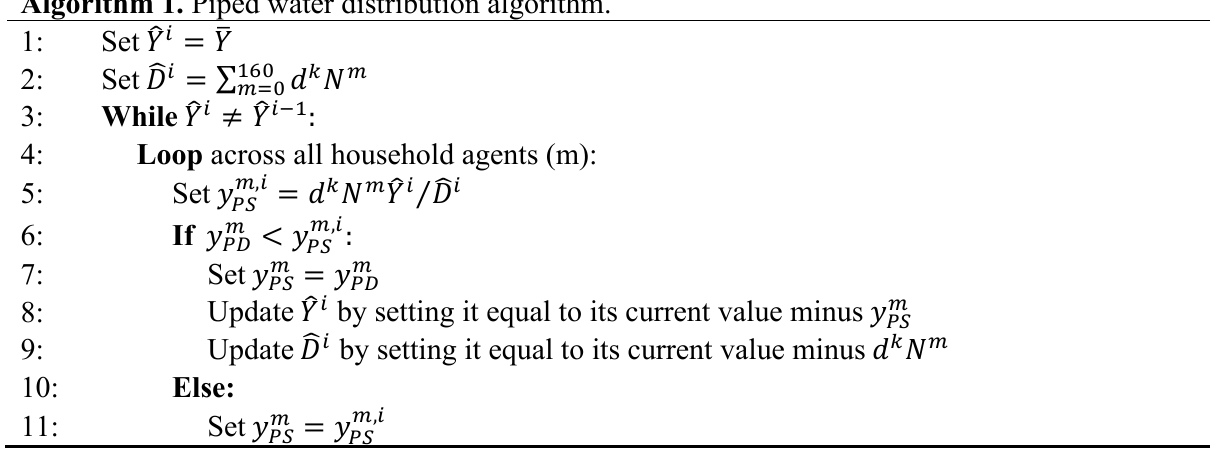
Algorithm 1. Piped water distribution